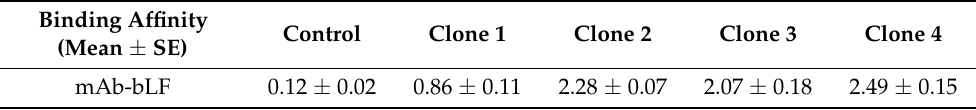
Table 3. Screening of rat anti-bLF mAb based on binding affinity (OD) at OD = 450 nm using